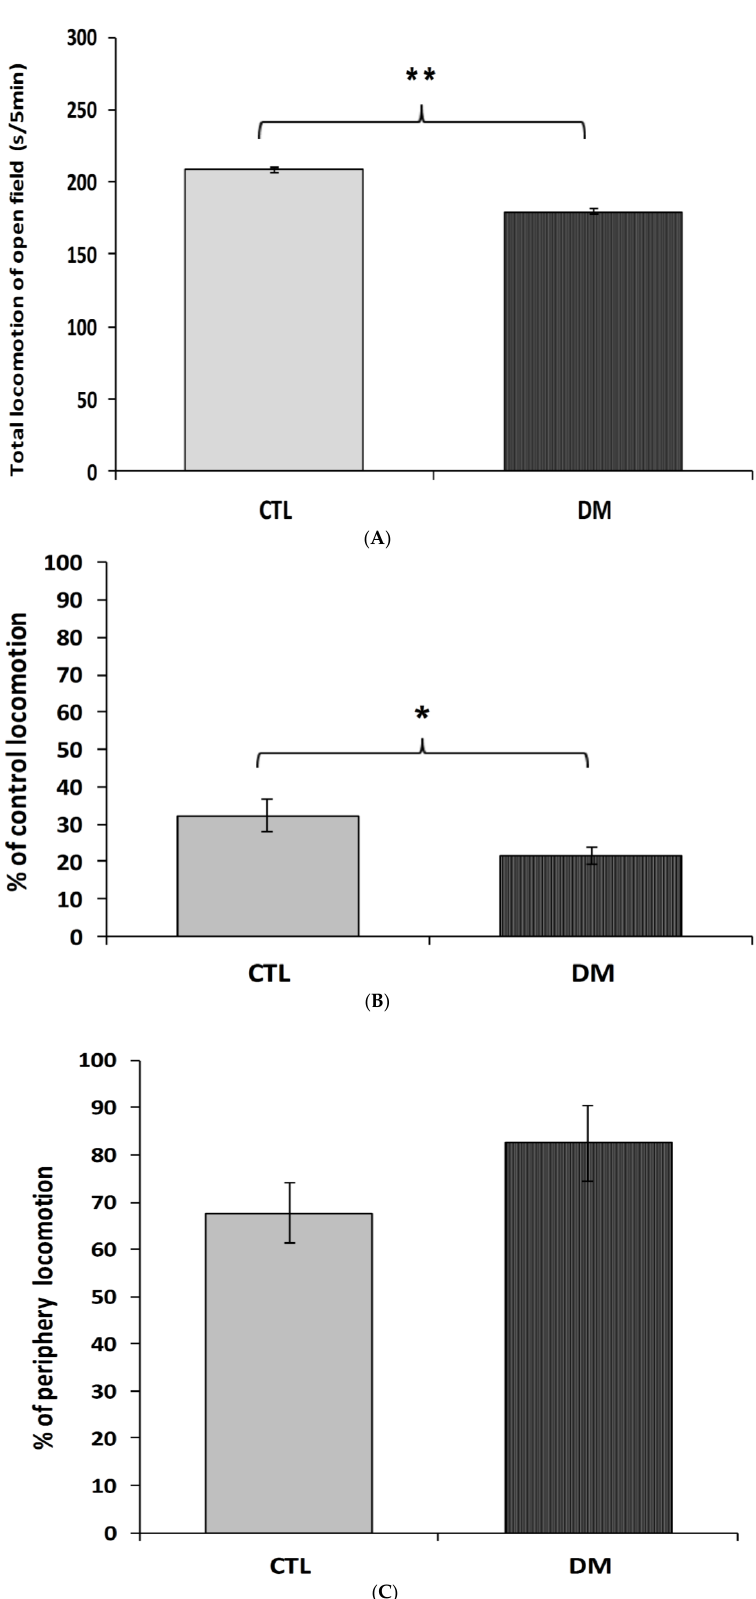
Figure 1. Spontaneous locomotor activity in diabetic mice. The locomotor activity was measured in terms of the squares number crossed ( A ), % time spent in the center zone ( B ), and % time spent in the periphery zone of the field ( C ). CTL: Control mice, DM: Diabetic mice. Each value represents mean ± SEM, n = 6. * p < 0.05; ** p < 0.01 vs. control.